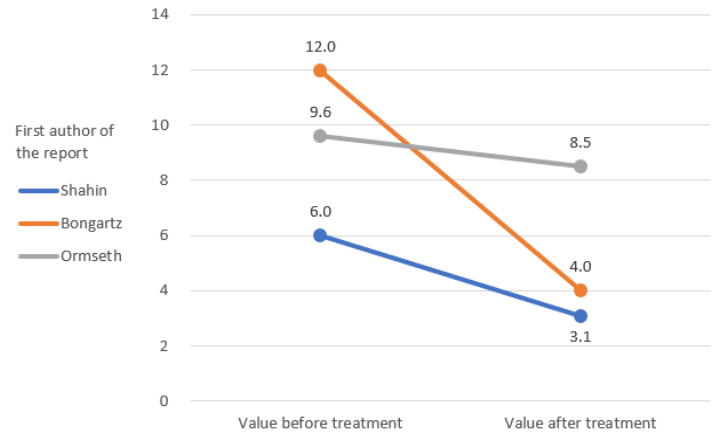
Figure 2. Initial and final values of tender joint count (TJC).